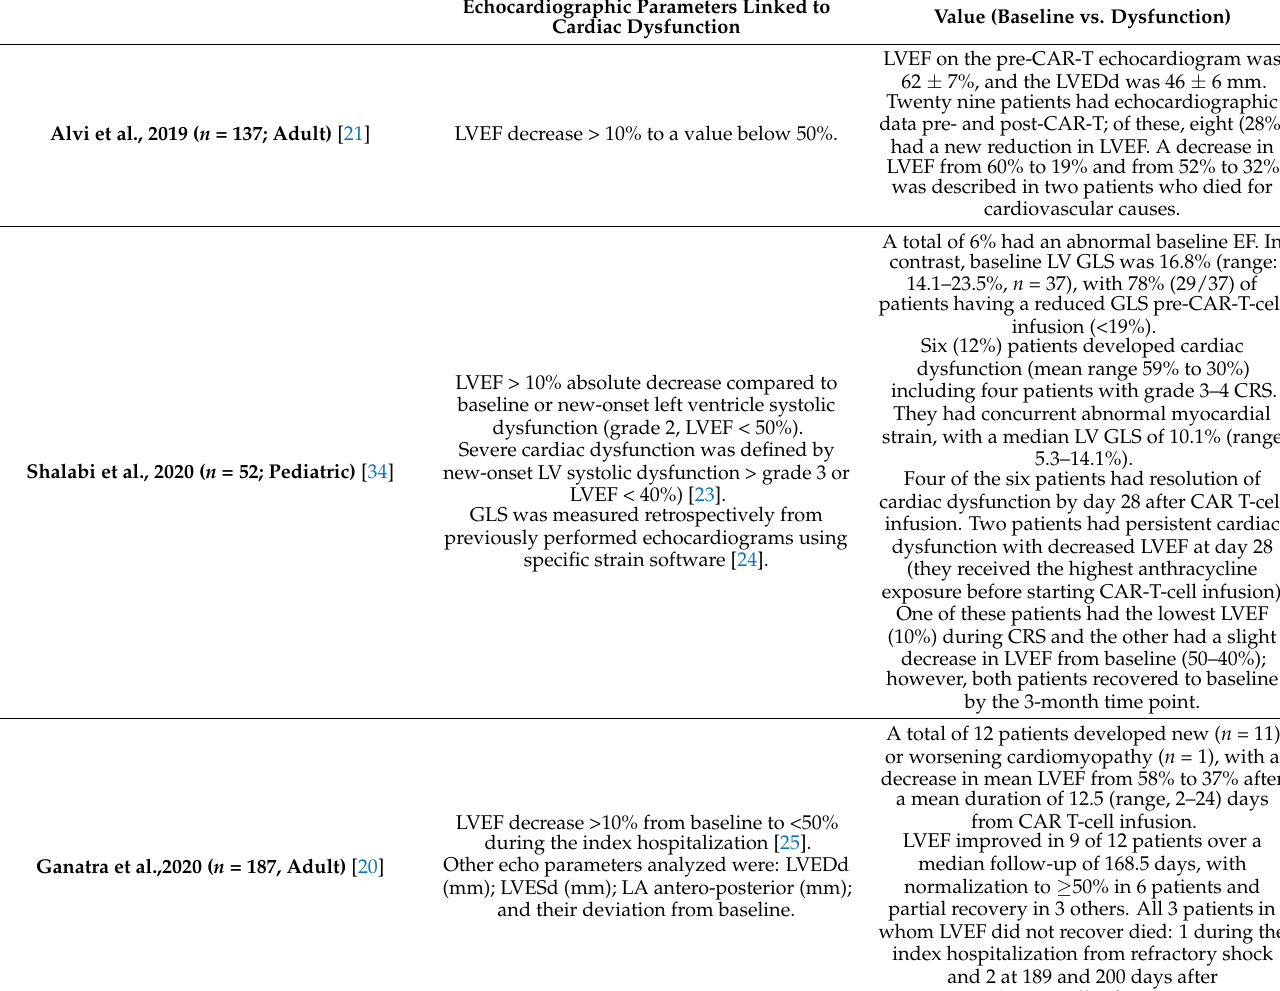
Table 5. Cont. Echocardiographic Parameters Linked to Cardiac